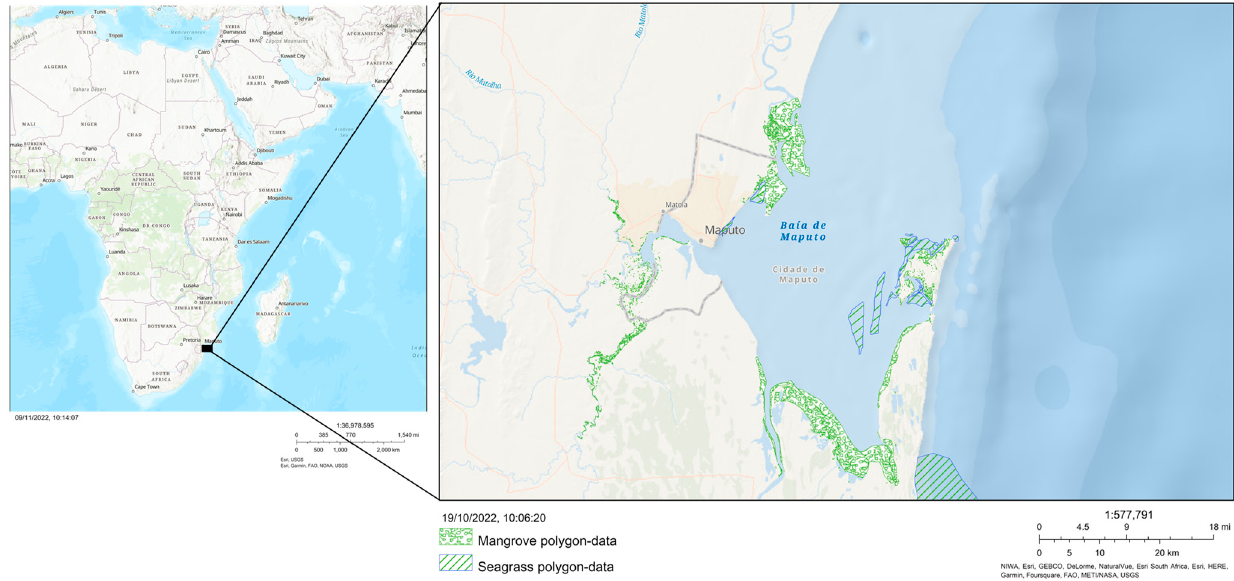
Figure 1. Location of mangrove forests and seagrass meadows in Maputo Bay, Mozambique (maps created with ArcGis WebBuilder, https://ulisboa.maps.arcgis.com/, accessed on 19 October 2022).